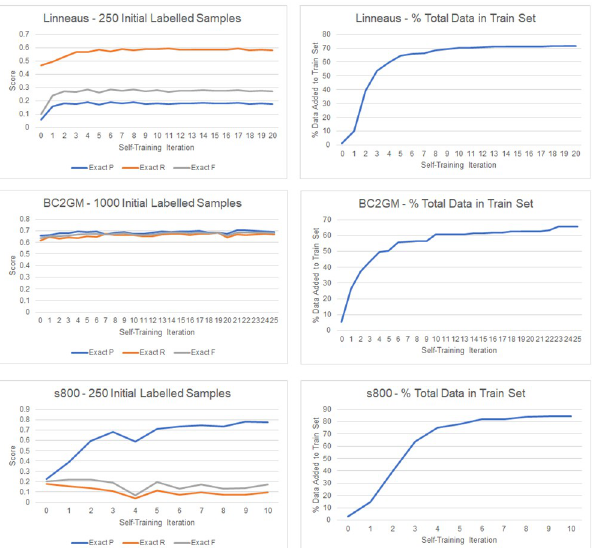
Fig 2. Performance of the BiLSTM-CRF after each iteration of self-training for three scenarios: S800 with 250 initial labeled sentences, Linnaeus with 250 initial labeled sentences, and BC2GM with 1000 initial labeled sentences. For each scenario, we also show the percentage of total available data (train + unsupervised) added to the training set after each iteration of self-training.